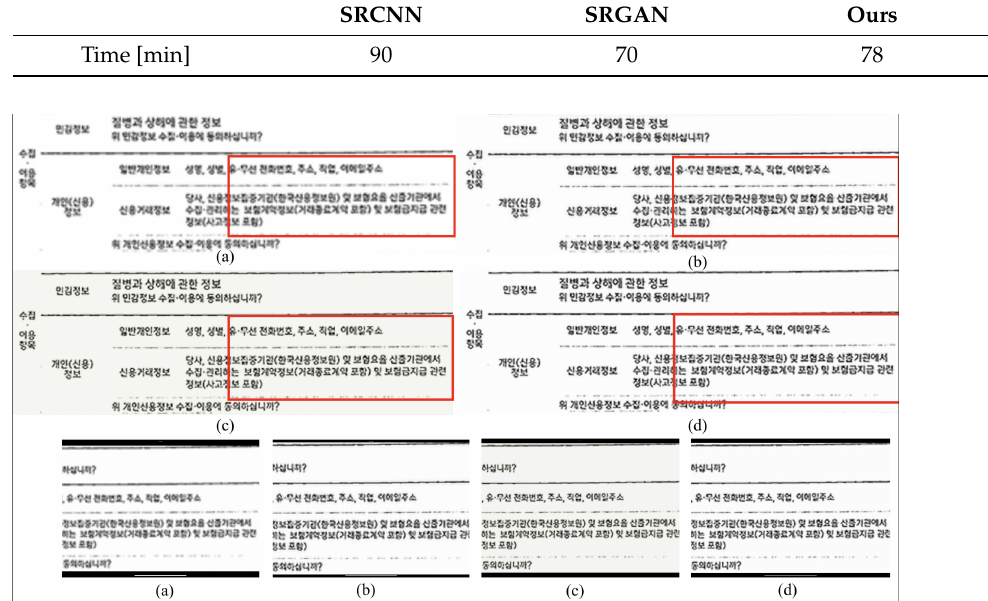
Figure 8. Comparison for each method: ( a ) The ground-truth low-resolution image. ( b ) Restored low-resolution image with SRCNN algorithm. ( c ) Restored low-resolution image with